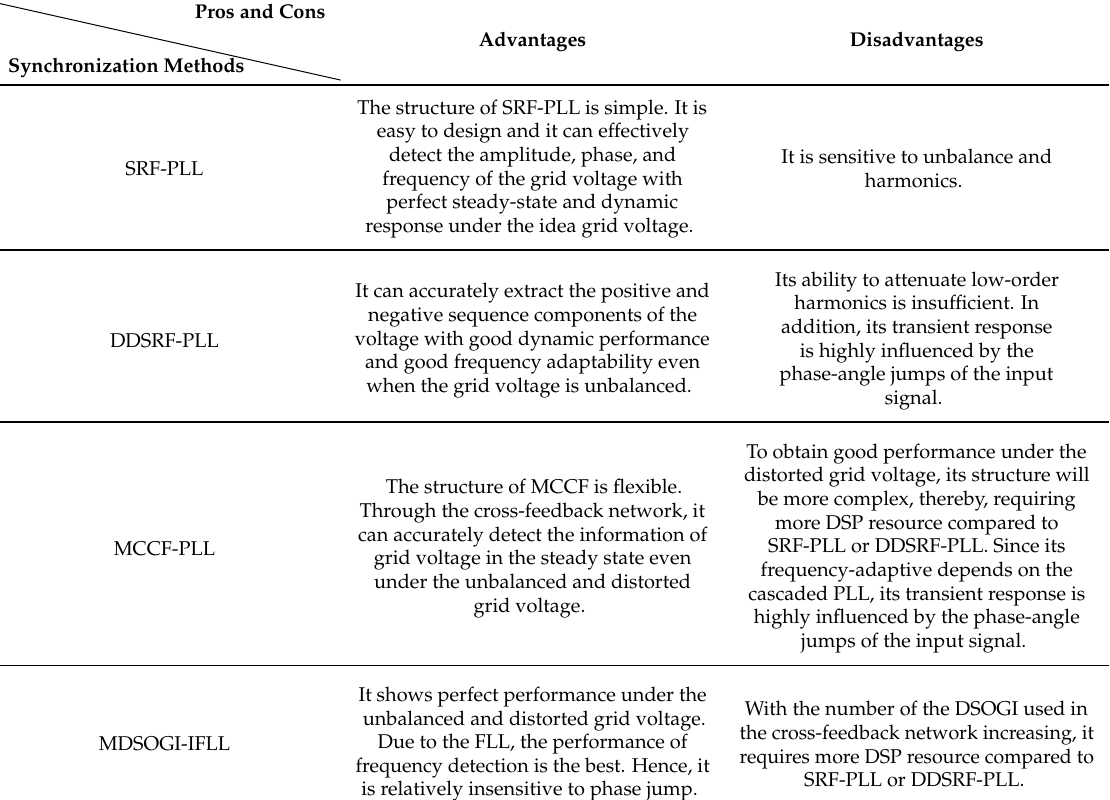
Figure 13. Waveforms of the grid voltage and estimated parameters by SRF-PLL (black line), DDSRF-PLL (green line), MCCF-PLL (blue line) and MDSOGI-IFLL (red line). Table 2. Brief comparison of the four synchronization